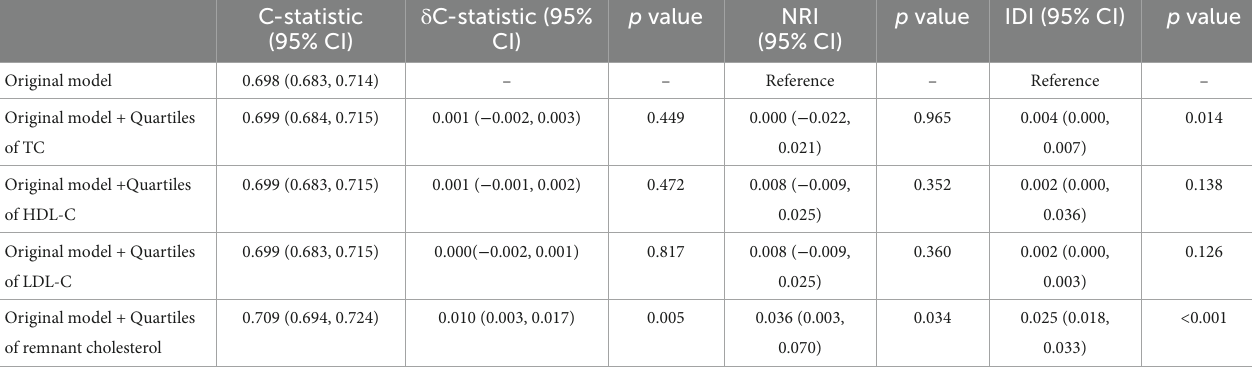
TABLE 3 C-statistic, δ C-statistic, NRI, and IDI of remnant cholesterol for predicting all-cause mortality.